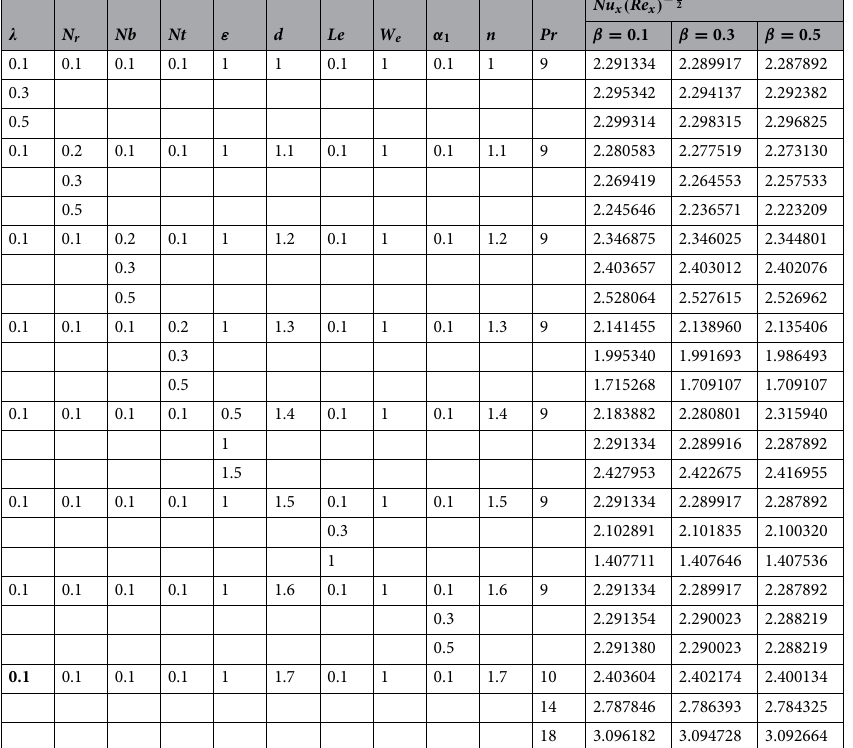
Table 2. Variation of Nu x ( Re x ) −